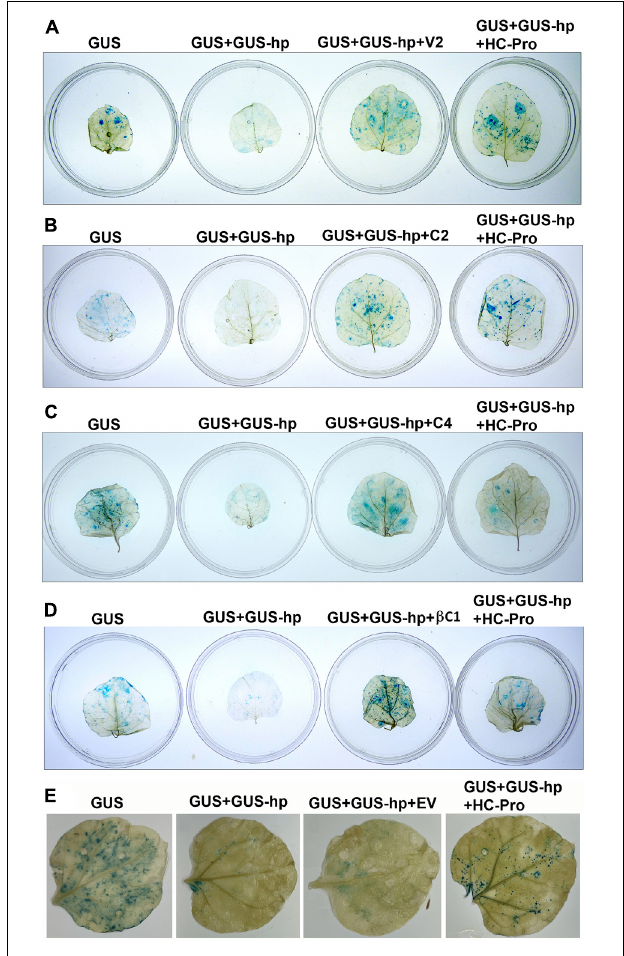
FIGURE 1 | V2, C2, C4, and betasatellite-encoded C1 protein ( β C1) are all RNA silencing suppressors from croton yellow vein mosaic virus (CYVMV)